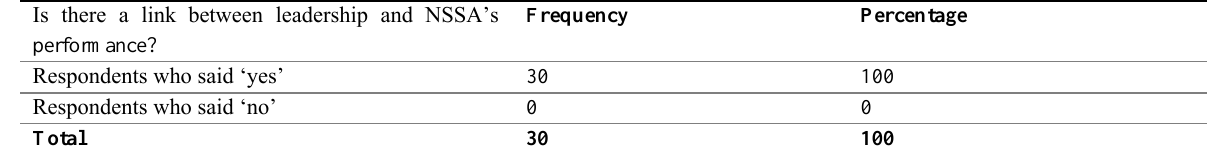
Table 2: The link between leadership styles and NSSA’s